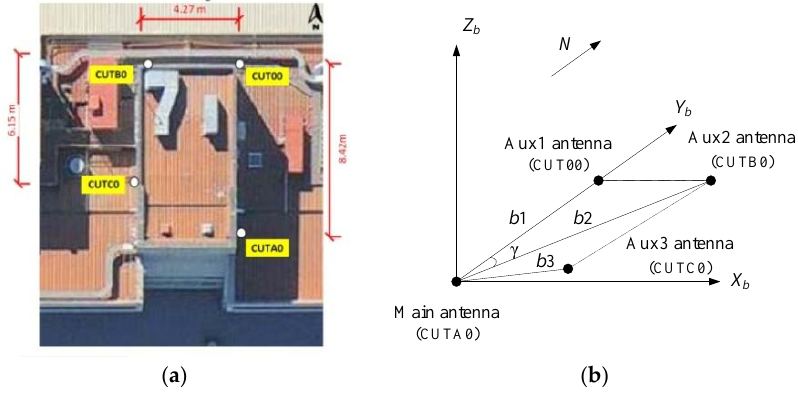
Figure 1. GNSS antenna used in static experiment: ( a ) is the antenna configuration; and ( b ) is the antenna geometry.